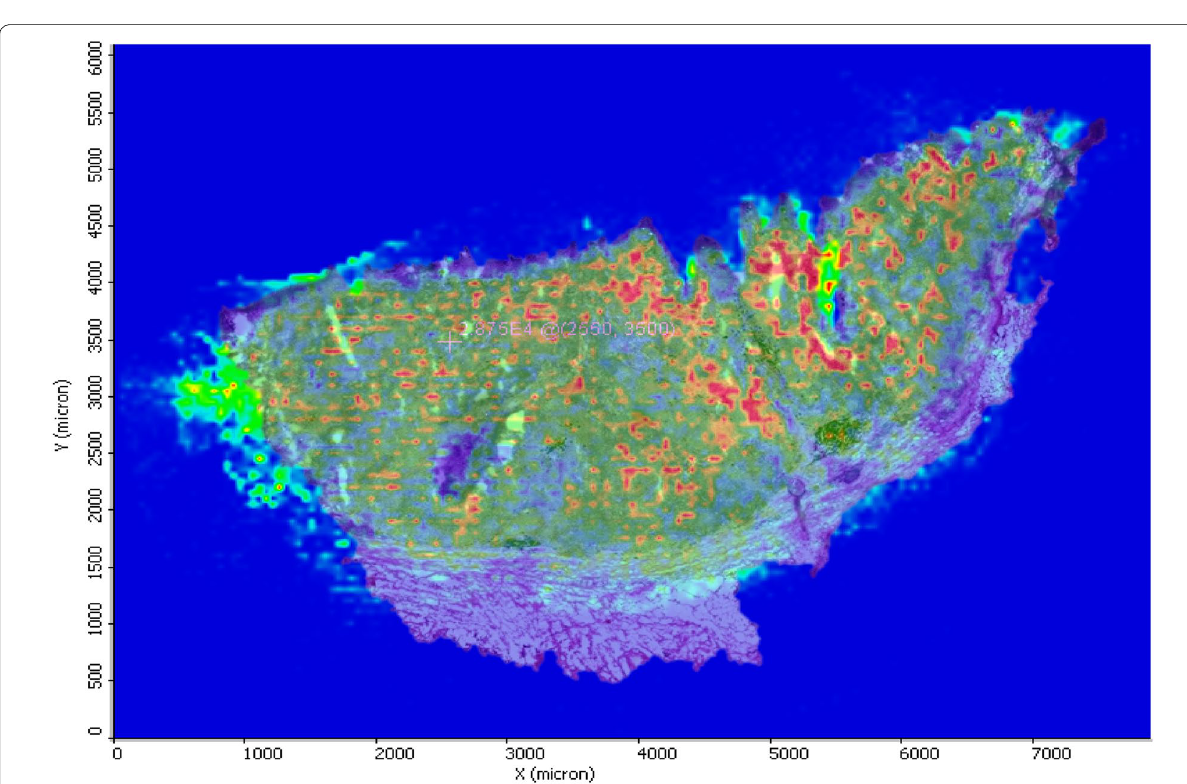
Fig. 7 MALDI mass spectrometry image overlay with histology from a patient cancer tissue sample isolated after surgery demonstrating tumour heterogeneity and metabolite localization. Spatial resolution